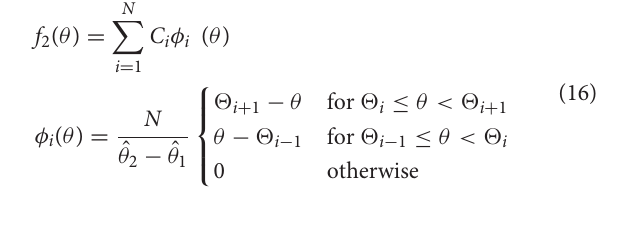
functions φ i , which are commonly known as tent functions: